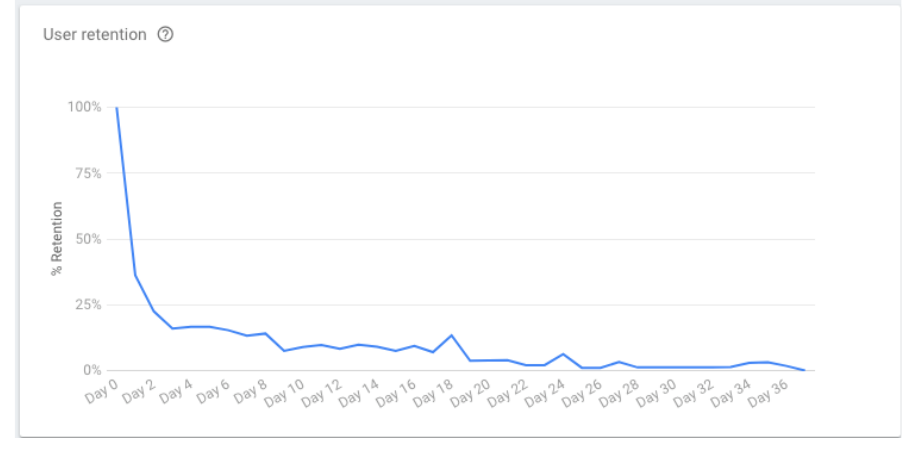
Figure 17. TeenPower mobile app — user retention (from 11 November to 29 December).